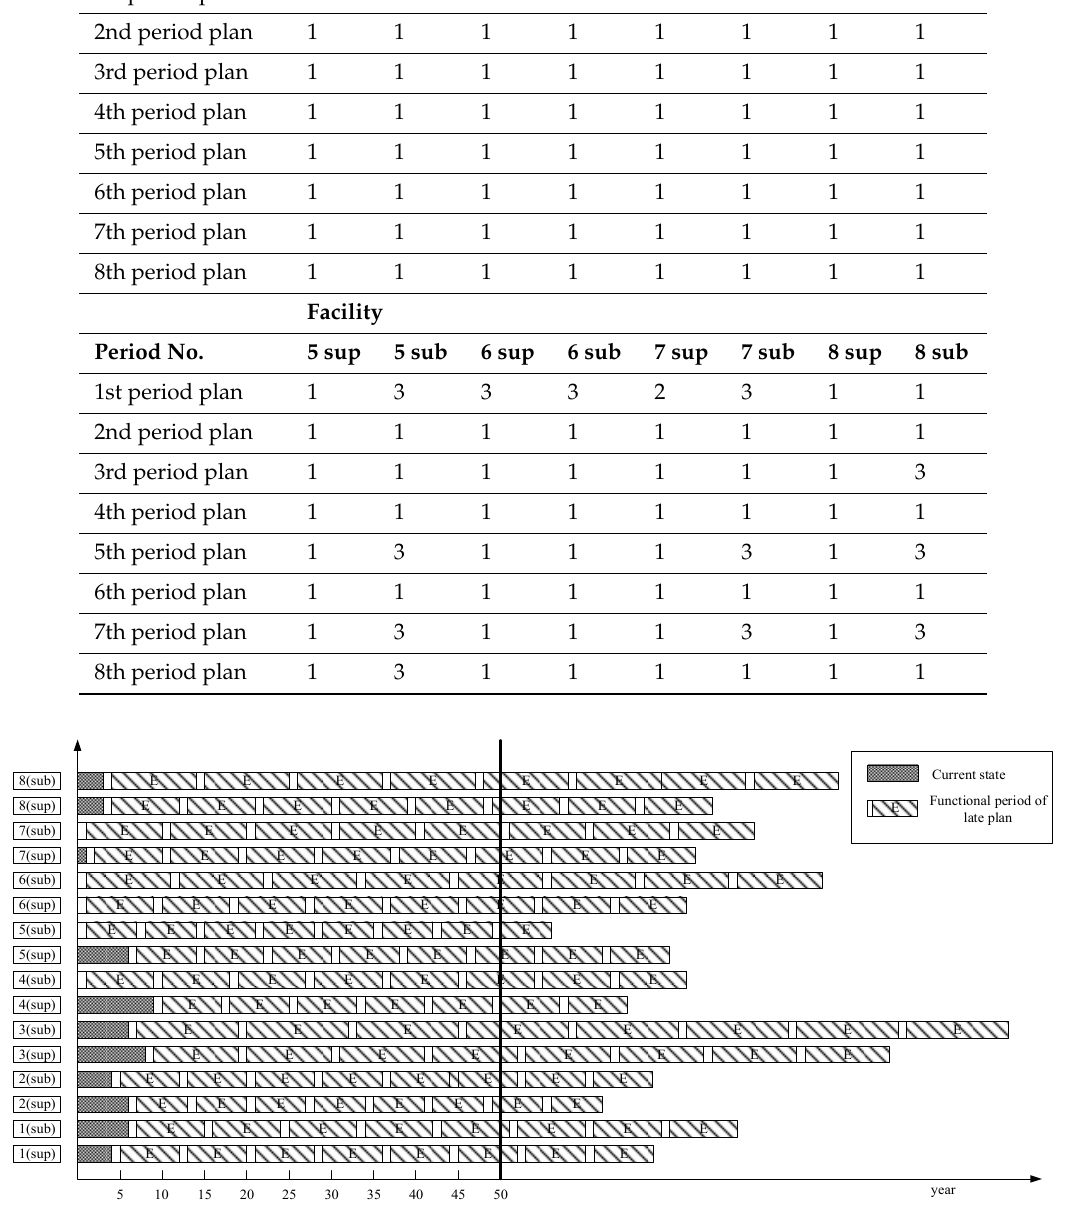
Figure 9. Simulation result of practical maintenance decisions.